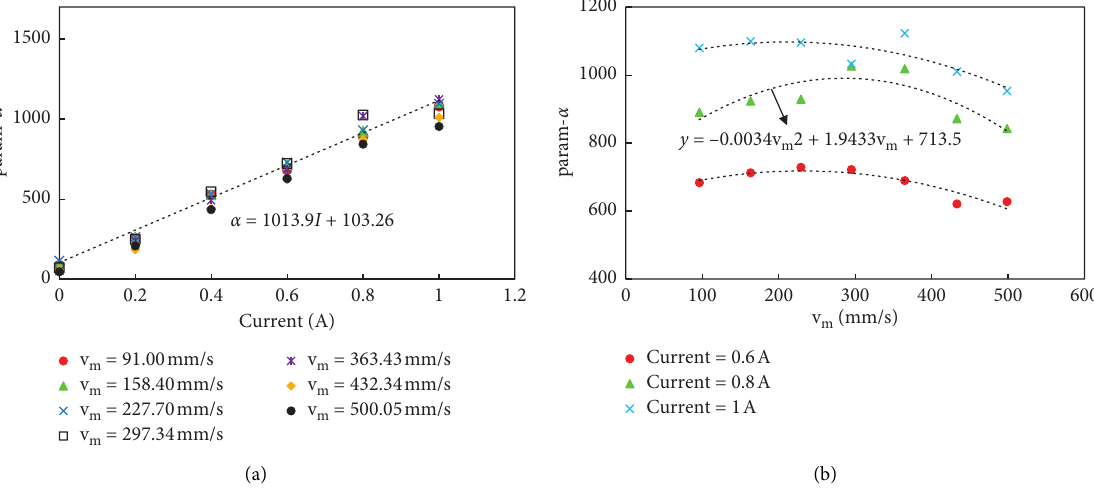
Figure 14: Identification results of parameter α .